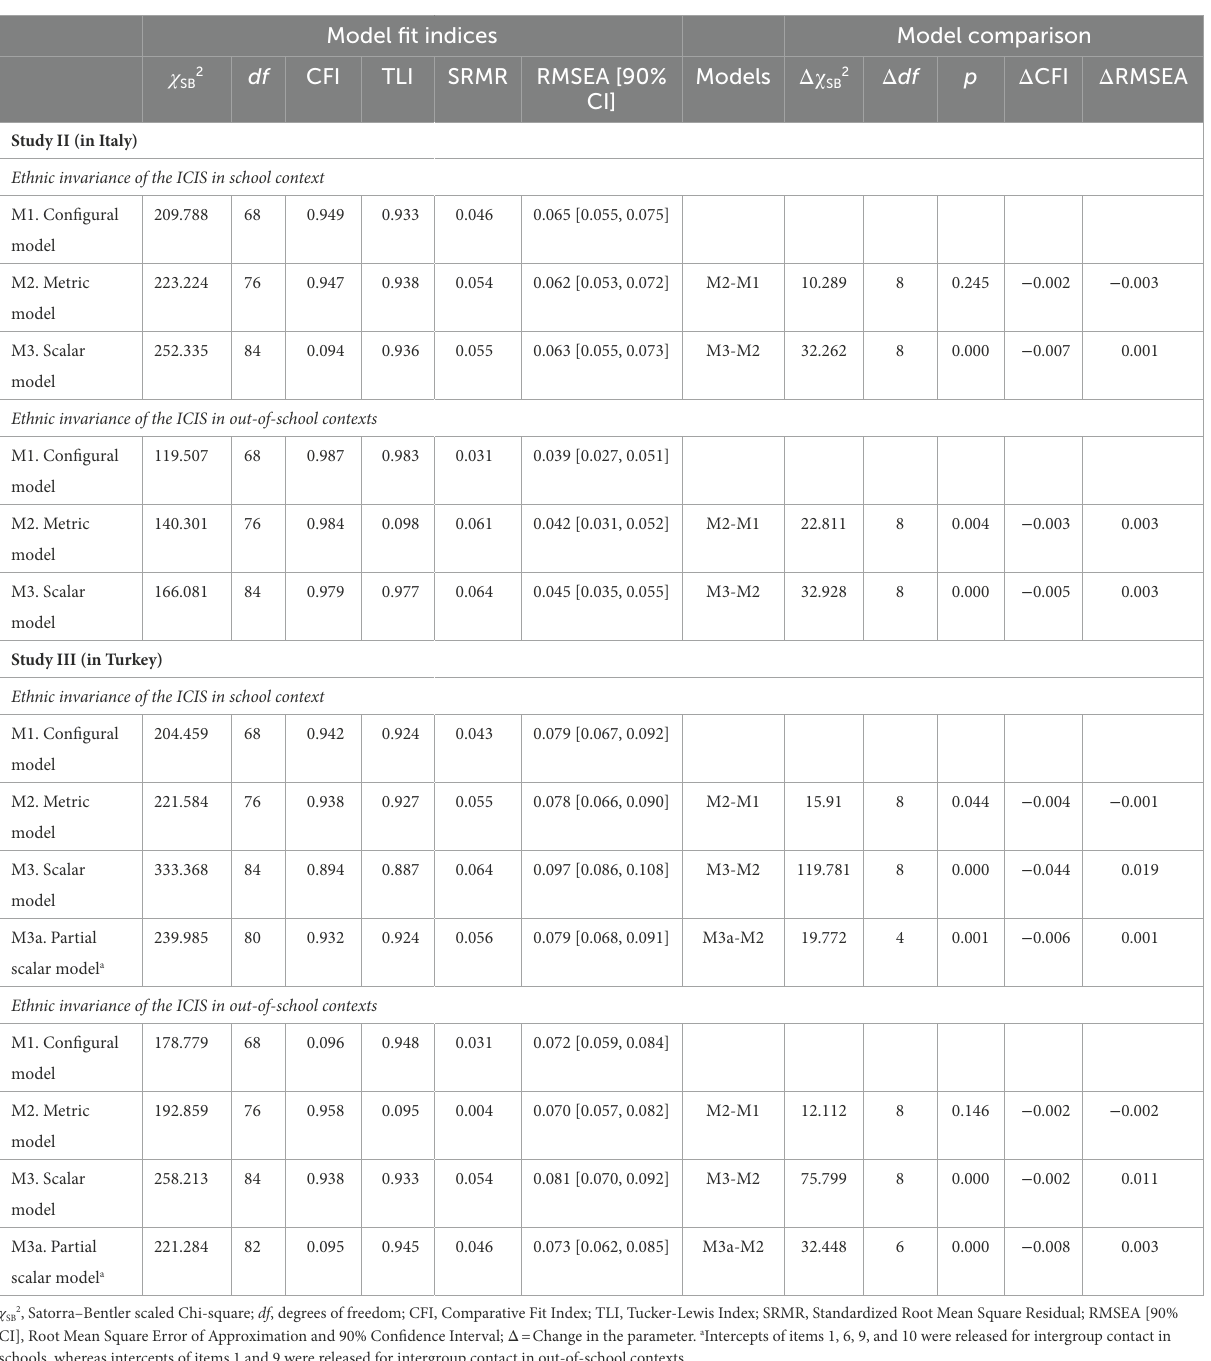
TABLE 4 Measurement invariance tests of the ICIS in school and out-of-school contexts in Studies II and